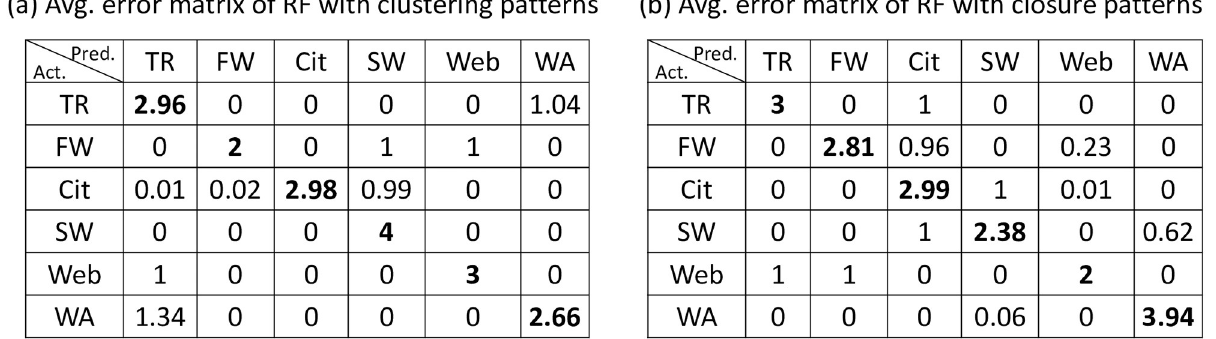
Fig 10. Average confusion matrices of Random Forest model with different feature sets.